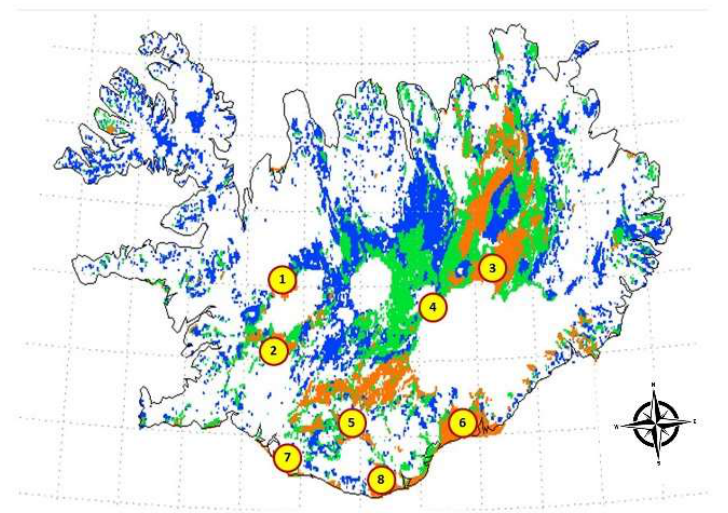
Figure 1. Areas vulnerable to erosion (extreme—orange, severe—green, considerable—blue) and hot–spots of dust emission (yellow circles); Dust hot-spots geographical names [1—Flosaskarð, 2—